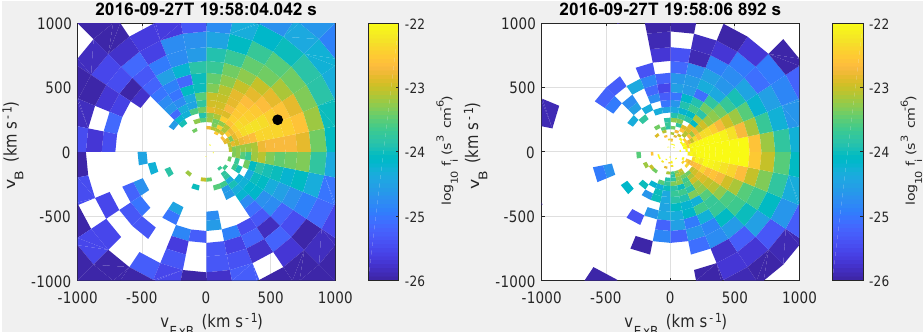
Figure 4. The two-dimensional cuts of ion velocity distributions in the plane formed by the local B and E × B vectors. The black dot denotes the predicted velocity by the Walén relation.